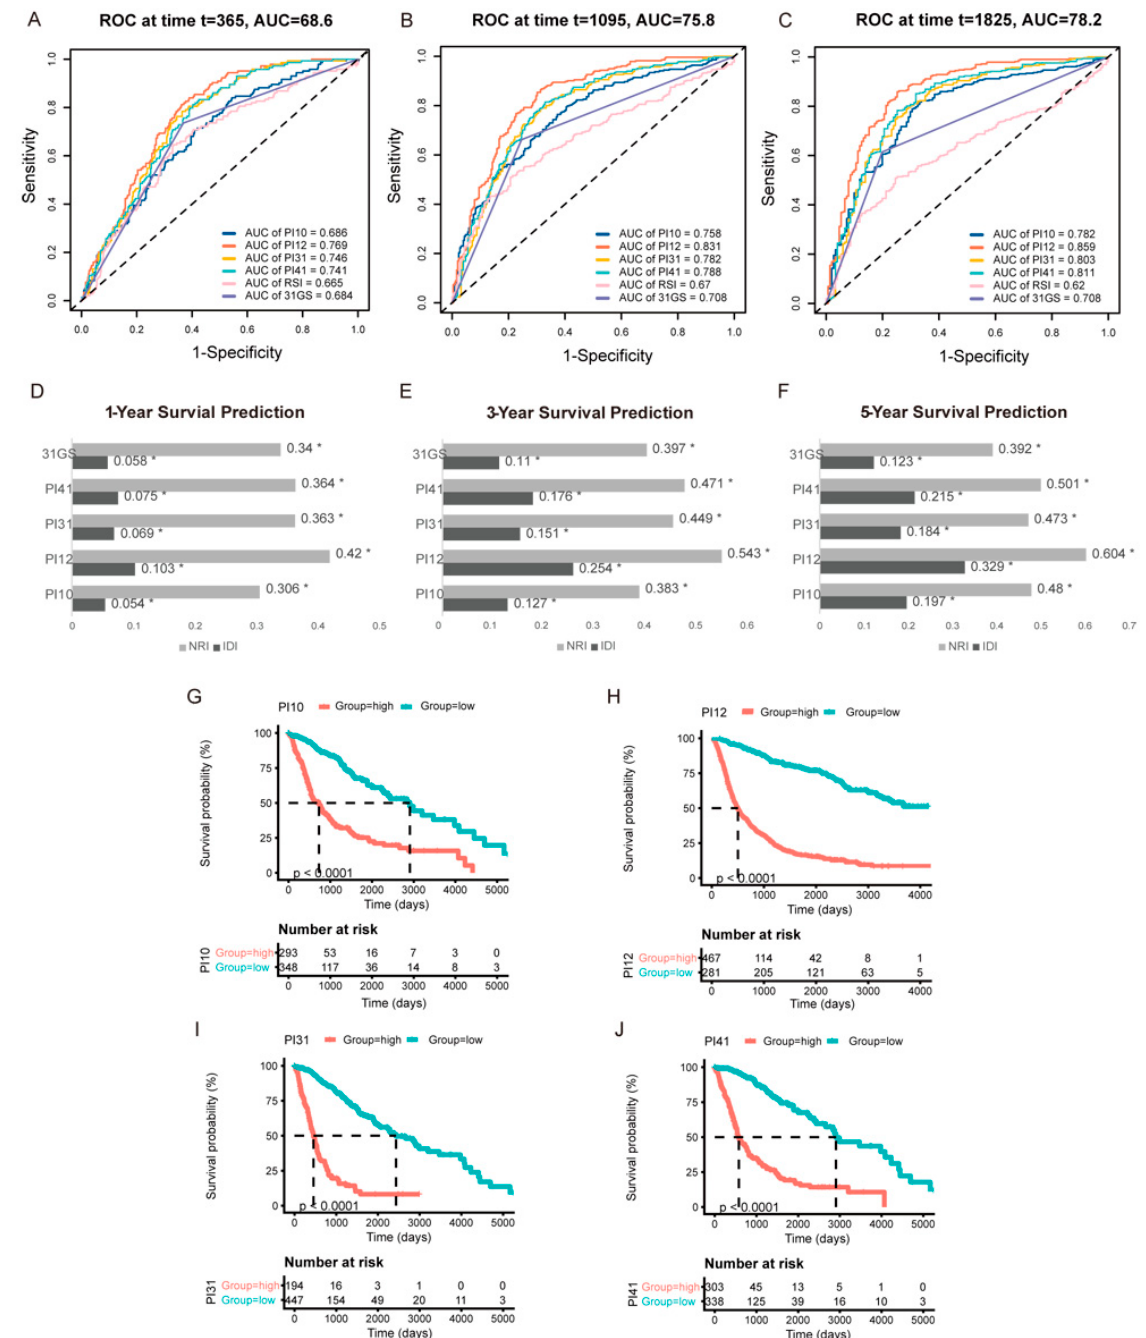
Figure 4. Internal validation of the selected markers in predicting glioma outcome in CGGA cohort. One − year ( A ), three − year ( B ), and fi ve − year ( C ) time − dependent ROC of the selected markers. AUC areas were calculated and exhibited below the figures. IDI and NRI were calculated to compare the predictive accuracy of the 6 selected markers for 1-year ( D ), 3 − year ( E ), 5 − year ( F )